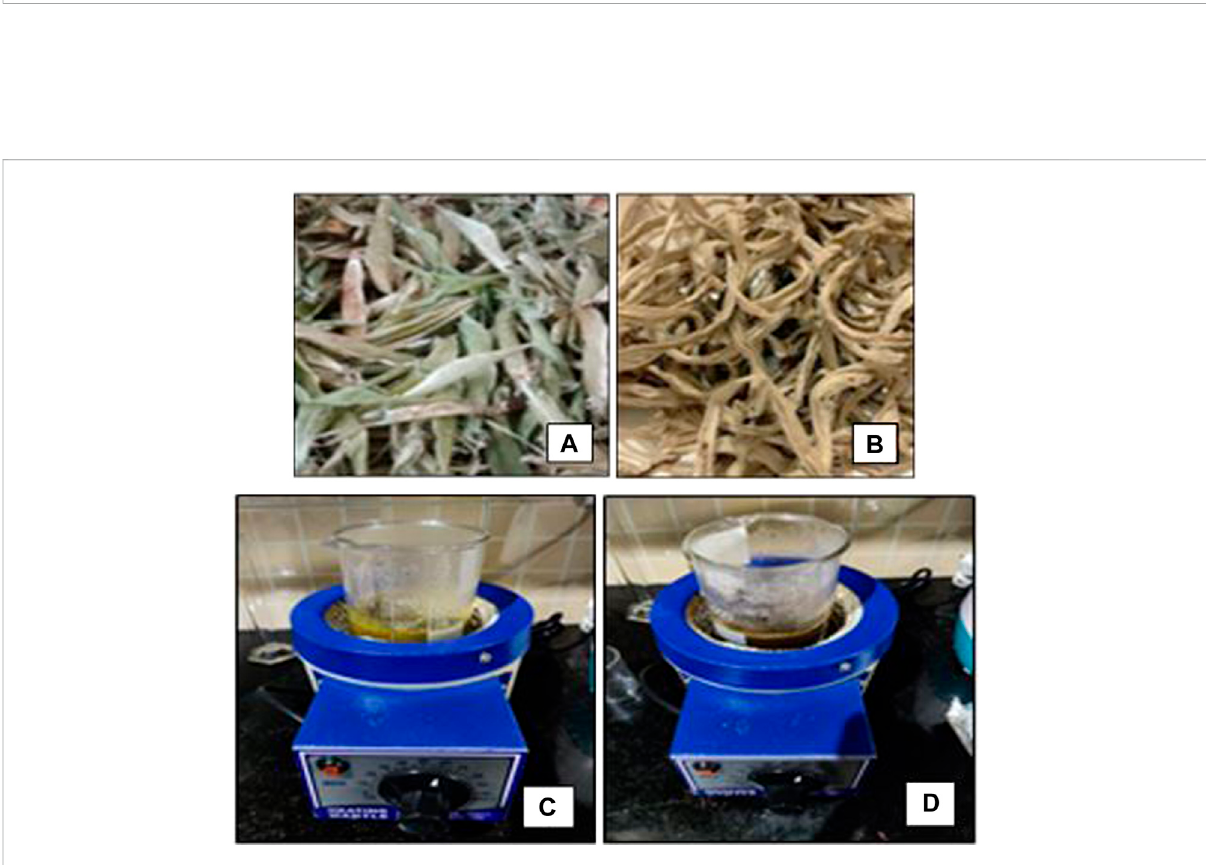
FIGURE 2 Dried vegetable peels of pea ( Pisum sativum) (A) and bottle gourd ( Lagenaria siceraria) (B) and the extraction of both vegetable peels (C,D)